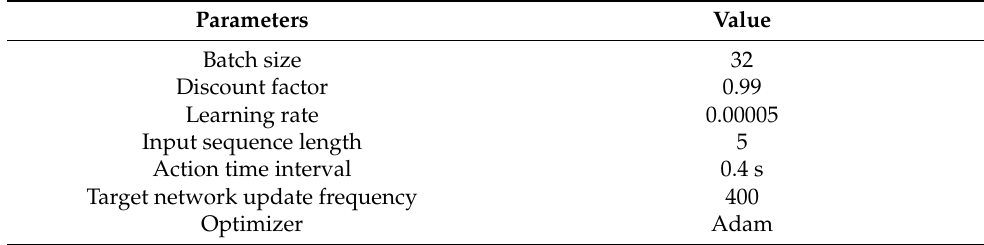
Table 8. Hyperparameters of Training the D3RQN.